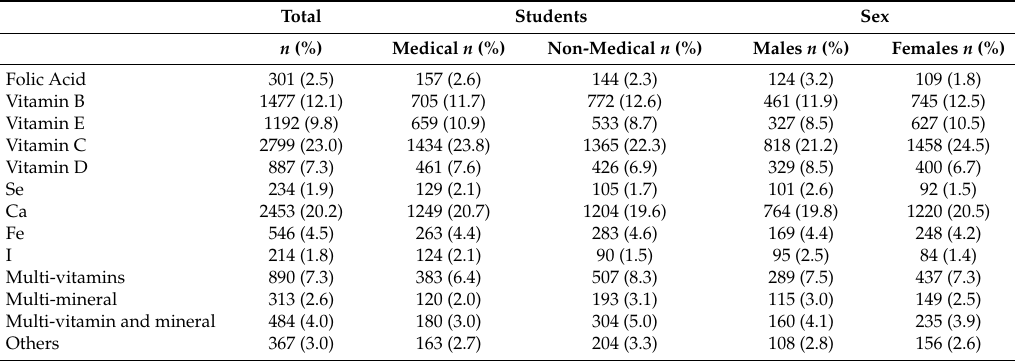
Table 6. Types of nutritional supplements used by medicine and sex